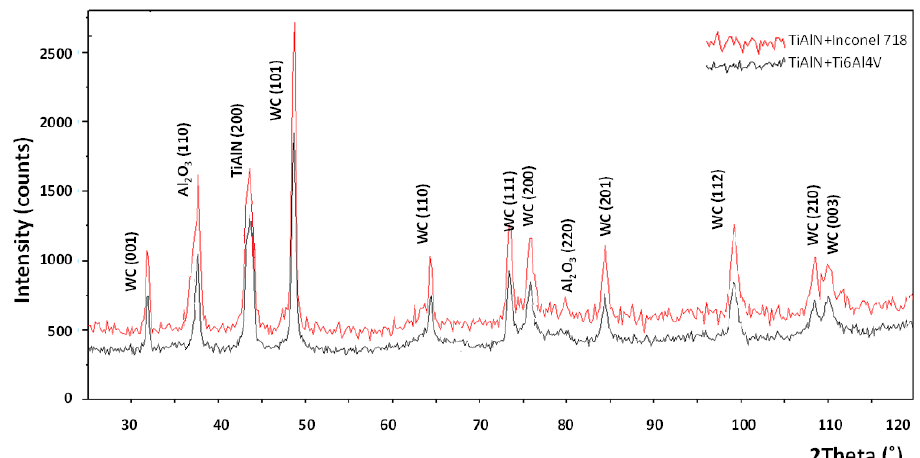
Figure 12. Average semi-quantitative chemical composition detected in points 1, 2 and 3 at the rake faces in Figures 8a and 9a after machining of IN718 ( a ) and Ti6-4 ( b ) alloys with the cutting speed of 200 m/min; machining time of 30 s (data specified in Table 6, respectively).